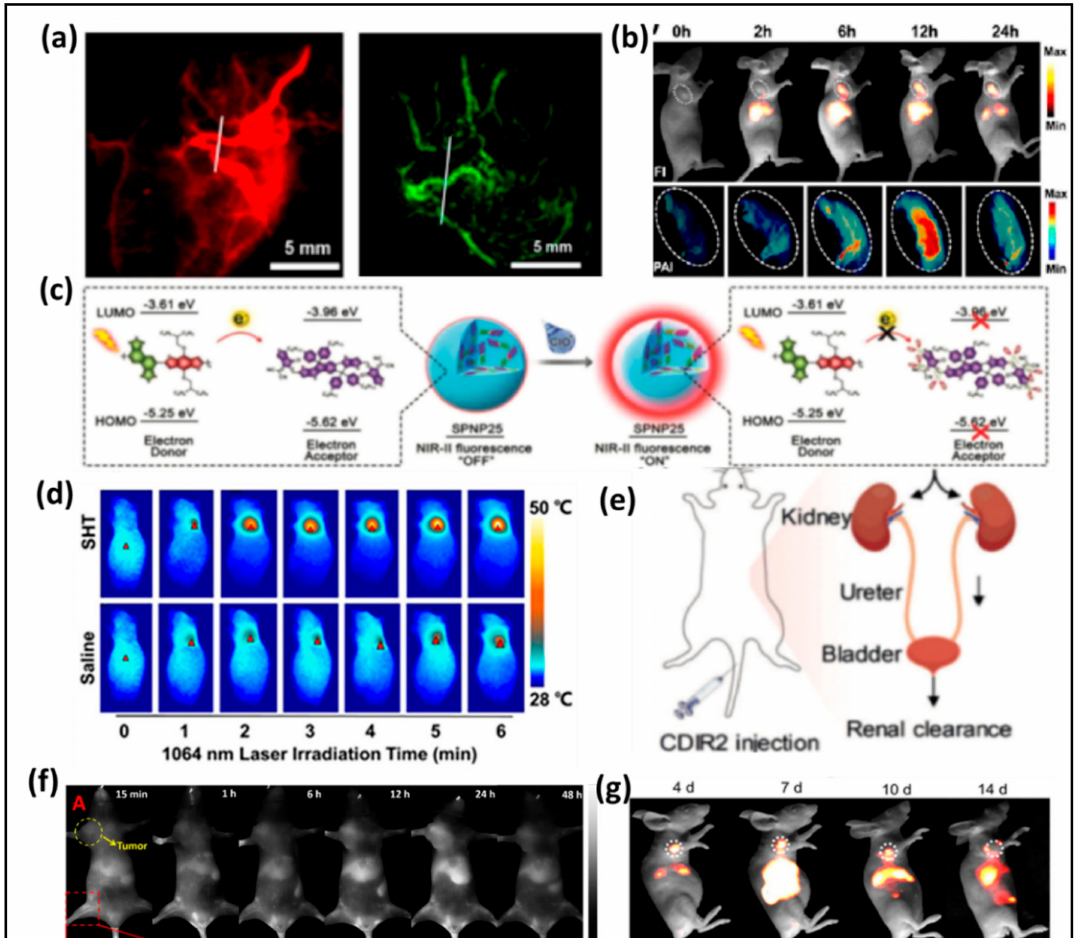
Figure 13. ( a ) NIR-II and PA imaging of blood vessels using Affibody–DAPs, ( b ) NIR-II and PA imaging of SY1080 NPS, ( c ) The mechanism of bioerasable intermolecular donor–acceptor interaction of SPNP25 with ClO − , ( d ) IR thermal images of living mice with 4T1 tumors under 1064 nm laser excitation (1 W cm − 2 ) at 48 h, ( e ) Diagram of the renal excretion of CDIR2 through the urinary system, ( f , g ) NIR-II images of monitoring the Pt(II) metallacycle-based NIR-II theranostic nanoprobe’s therapeutic response in HepG2 tumors. Reprinted with permission from [201]. Copyright © 2020,